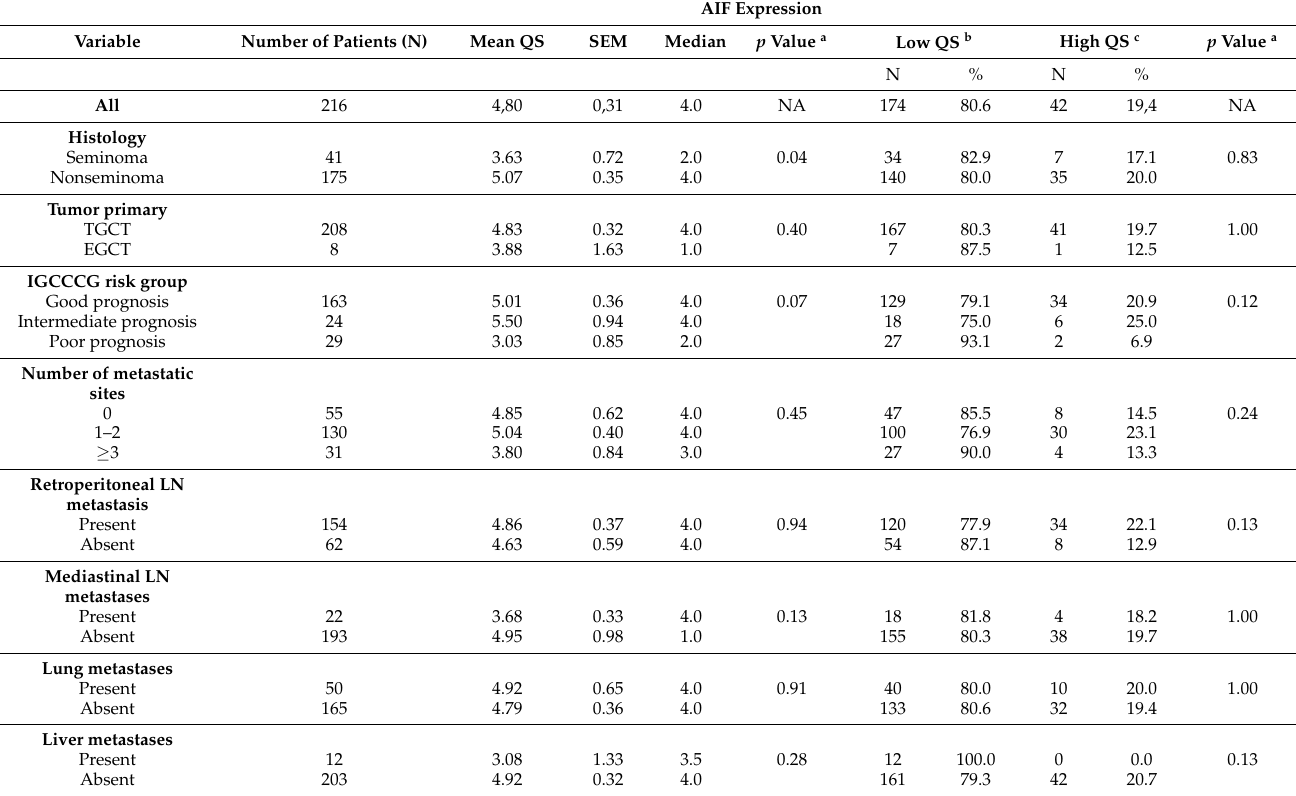
Table 3. Association between AIF expression in primary tumor and patients/tumor